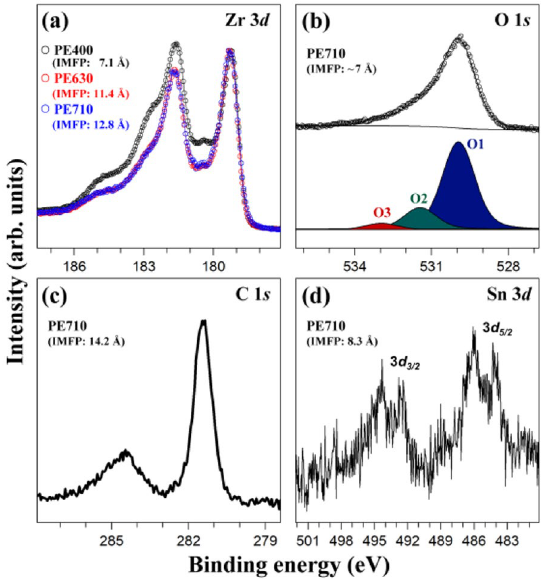
Figure 1. ( a ) Zr 3 d , ( b ) O 1 s , ( c ) C 1 s , and ( d ) Sn 3 d HRPES spectra obtained from ZIRLO before the deposition of H 2 O, where PE means the photon energy (eV). Black, red, blue open circles in ( a ) indicate Zr 3 d spectra acquired at the photon energies of 400, 630, and 710 eV, respectively, which were normalized using Zr 3 d 5/2 peak of zirconium metal at 179.3 eV. The dots and the solid lines in ( b ) represent the experimental values and the peak fitting results, respectively.